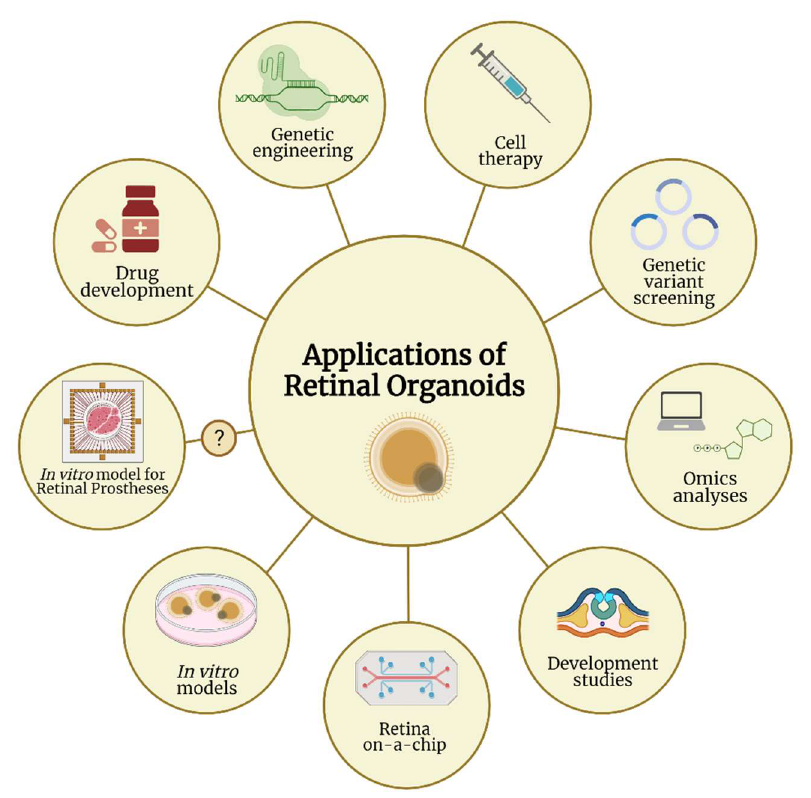
Figure 2. Applications of retinal organoids in various research fields. Retinal organoids carry great potential to be utilized in many research areas, from genetic engineering, omics analyses, and drug development to developmental studies and cell therapy. Retinal organoids can also be used as human in vitro models and in the recent emergence of retina-on-a-chip technology. One additional potential utility is to test the efficiency of retinal prostheses, when retinal organoids are used as human in vitro models recapitulating the disease pathophysiology. Despite few studies proving that retinal organoids are light-responsive on electrode arrays, this application on retinal prostheses has not yet been addressed in any publication, which justifies the question mark in the figure.